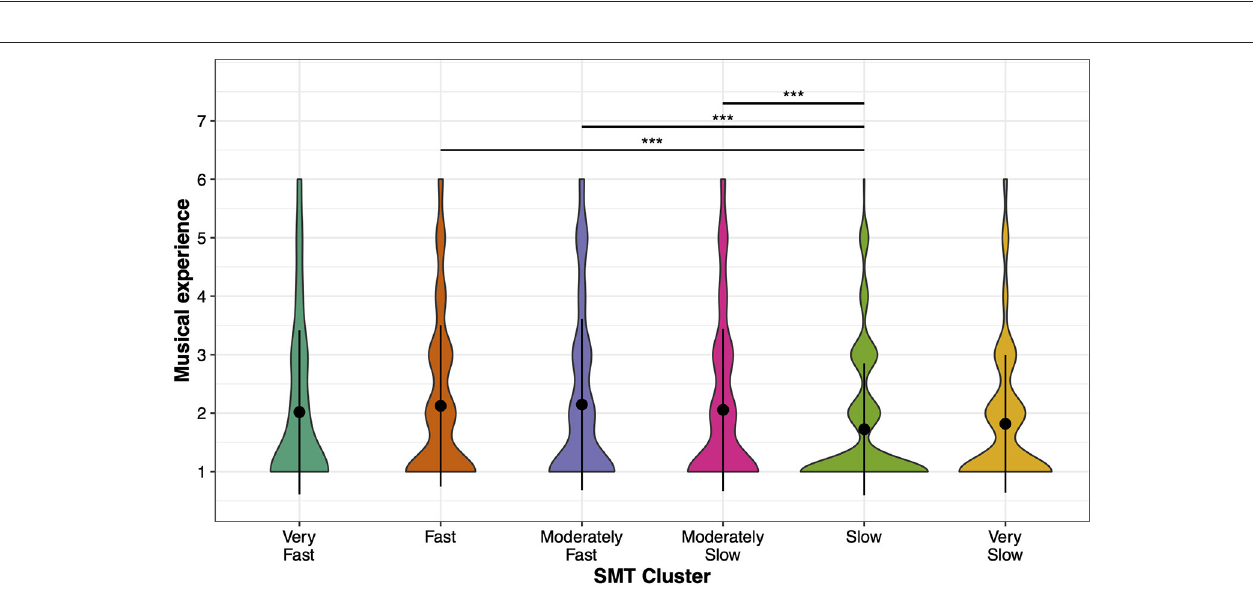
FIGURE 4 | Distribution of musical experience per SMT cluster. Mean values (black points) and standard deviations (error bars) of participants’ musical experience for each SMT cluster. Colored areas show the distribution of musical experience. Asterisks indicate significant differences: *** p < 0.001.